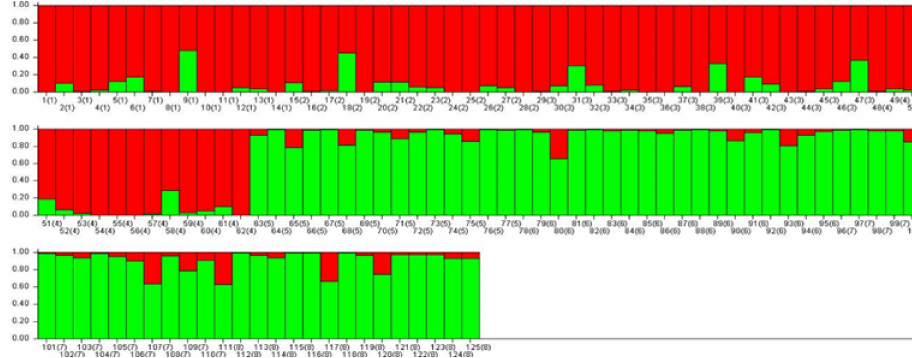
Figure 4. Population structure plot of 125 A. exscapus subsp. transsilvanicus individuals. Cluster I (green) contained 59 pure individuals from S ă bed, Vii¸soara, Valea Florilor, and S ă rm ă ¸sel Gar ă populations, while cluster II (red) included 57 pure individuals from Mil ă ¸sel, Beleni, G ă d ă lin, and Siliva¸su de c â mpie populations. Individuals with admixed population assignment were from Mil ă ¸sel (1), Beleni (1), G ă d ă lin (3), Valea Florilor (2), and Vii¸soara